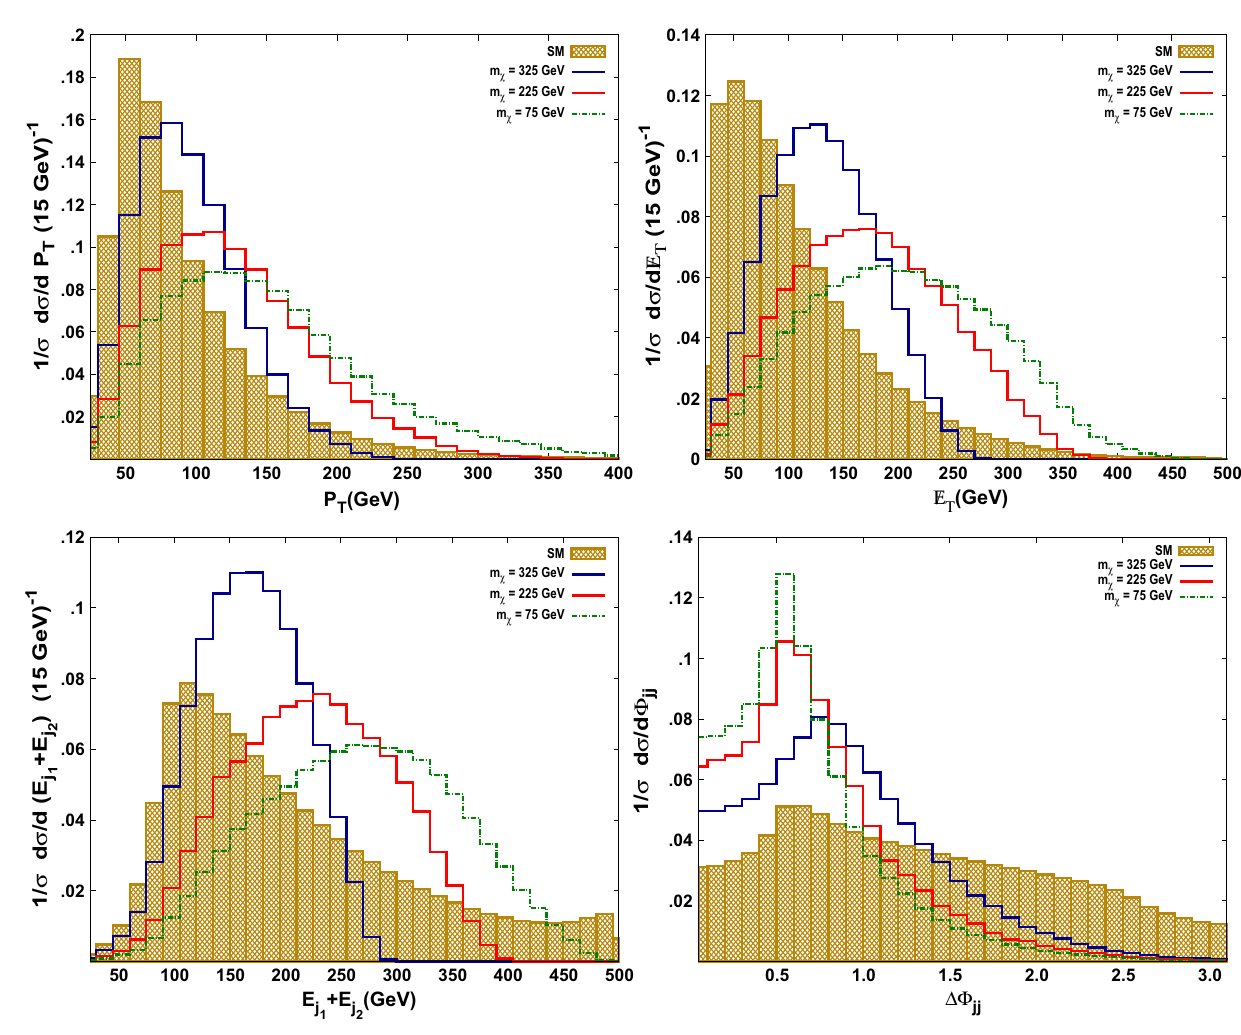
√ s = 1 TeV, Λ =1 TeV and M χ = 75, 225 and 325 GeV with α l = α l = α l = α l = 1. The bin width is 0.1 for the Δφ ii SS PP SP PS → j j + E distribution, while it is 15 GeV for the (cid:15) E T and E j j 1